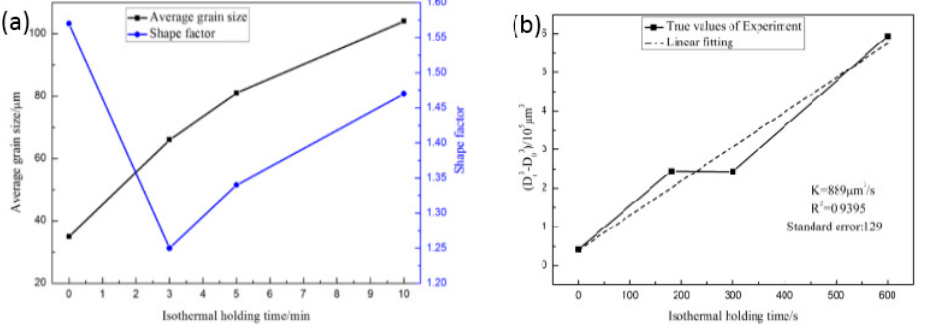
Figure 5. Changes of the primary particle size and shape factor with the holding time ( a ) and the linear fitting curve ( b ).